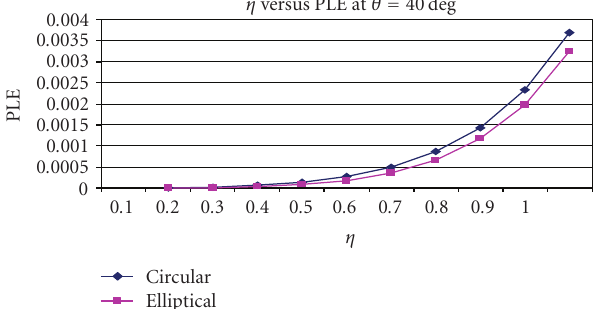
Figure 5: Normalized phase error for scanning angle θ = 40.